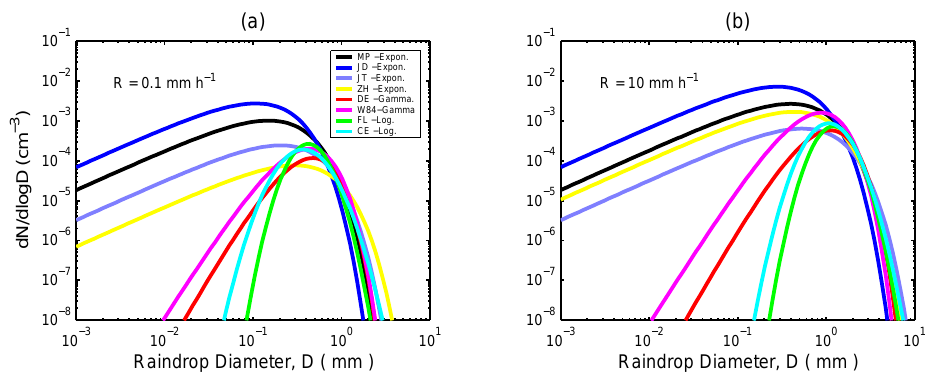
Fig. 4. Eight different raindrop number size distributions for rainfall intensities of (a) R =0.1mmh − 1 , and (b) R =10mmh − 1 : MP